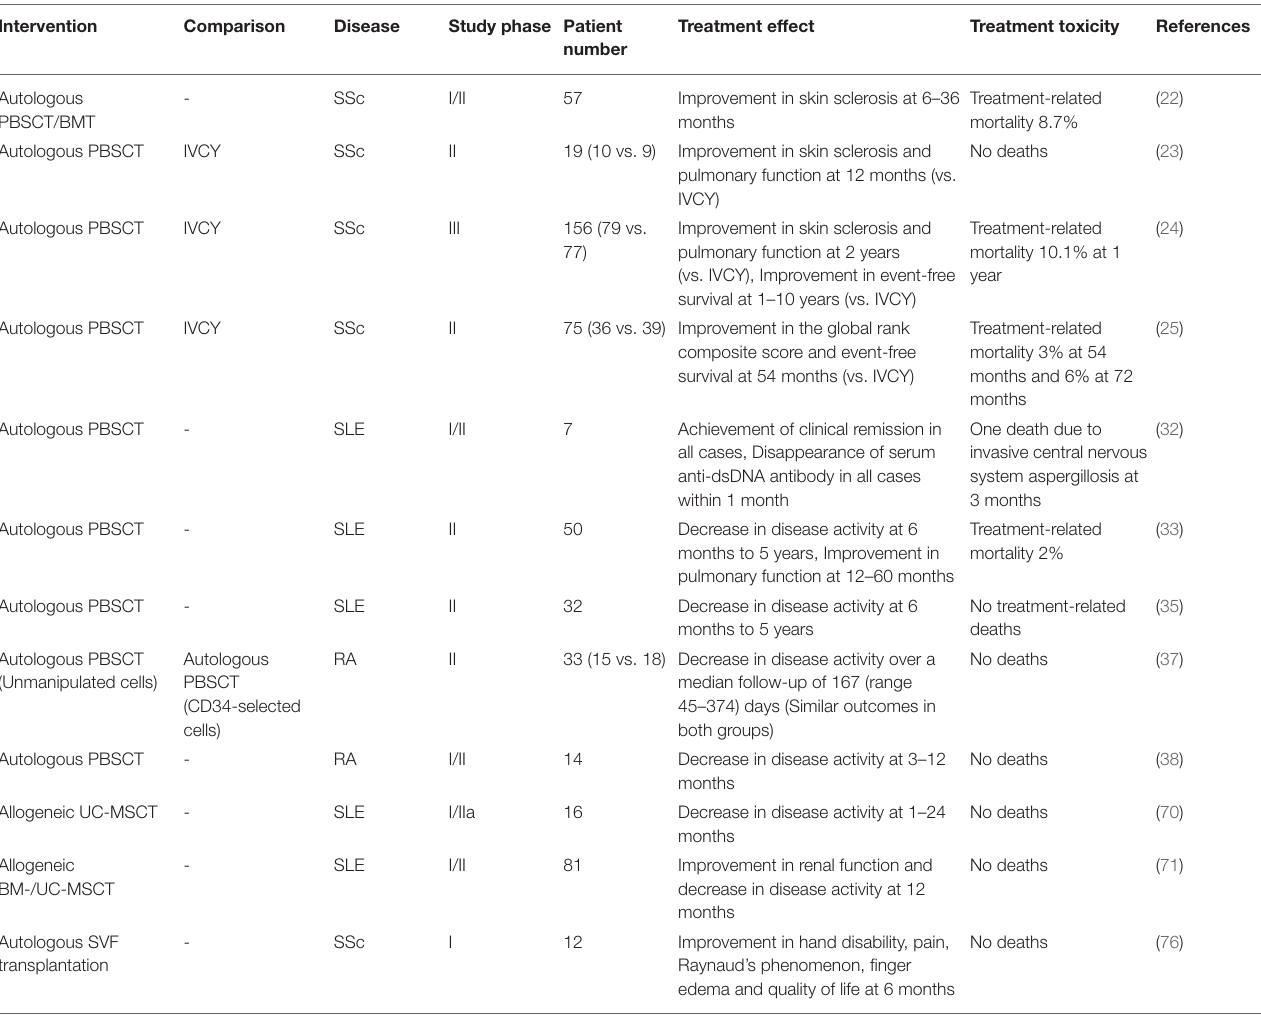
TABLE 2 | Clinical trials using regenerative medicine for rheumatic diseases.